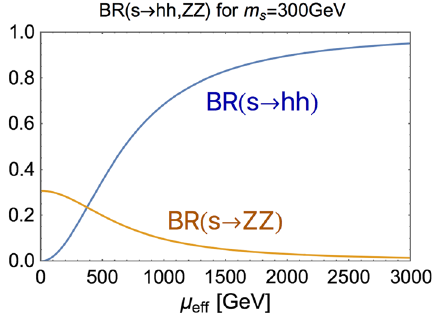
Fig. 9 Branching ratios BR ( s → hh ) and BR ( s → Z Z ) at m s = 300GeV as functions of μ